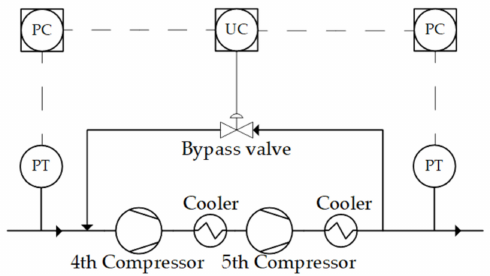
Figure 3. Configuration of a bypass valve in compressor skid